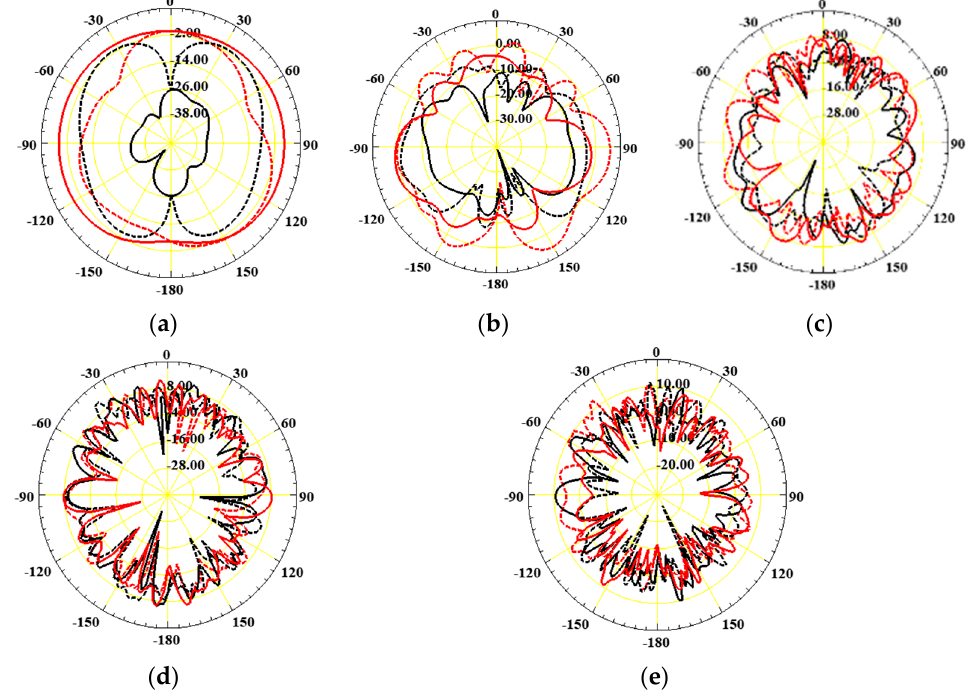
Figure 7. The 2D far-field patterns in E-plane and H-plane: ( a ) 24.1 GHz, ( b ) 67.1 GHz, ( c ) 129.1 GHz, ( d ) 249.1 GHz, ( e ) 287.1 GHz (red solid—co-polarized E-plane; black solid—cross-polarized E-plane; red dotted line—co-polarized H-plane; black dotted line—cross-polarized H-plane).